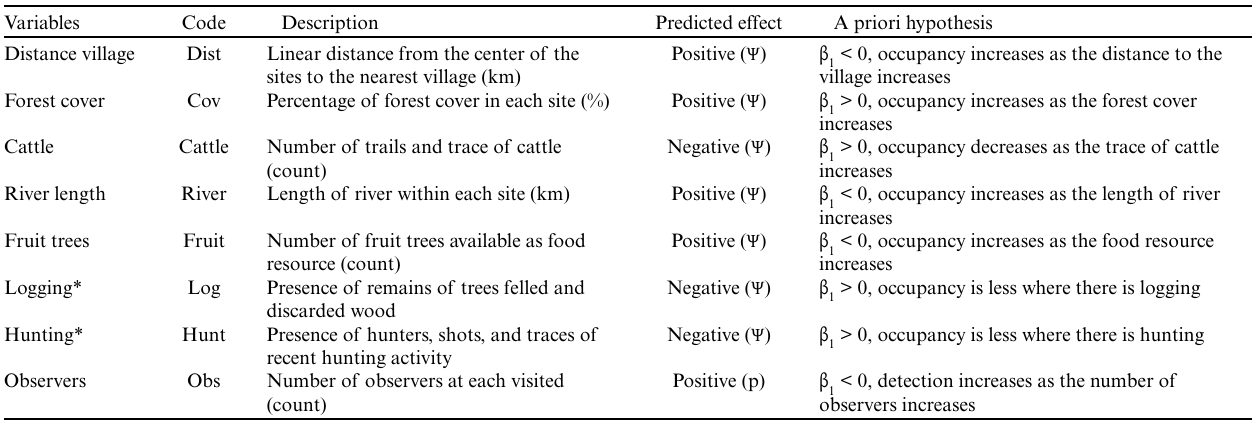
Table 1 . Description of ecological and human variables, their predicted influence on occupancy ( Ψ ), on detection probability (p), and a priori hypothesis ( β 1) for modeling the occupancy of Bare-faced Curassow of the Humid Chaco, northern Argentina. The variables with an asterisk were not included in the occupancy